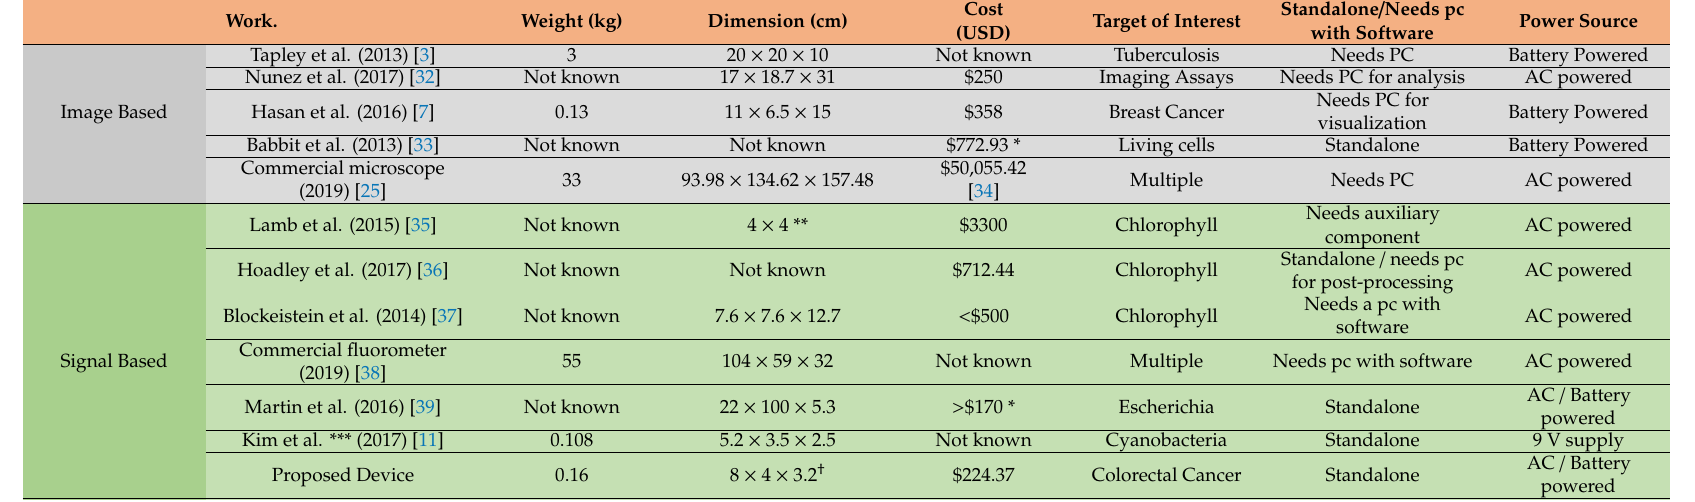
Table 2. Comparison of the developed device with other devices in market or in